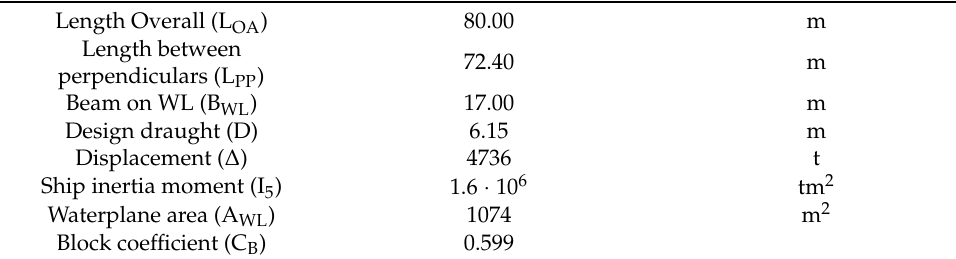
Table 1. Main data of “Laura